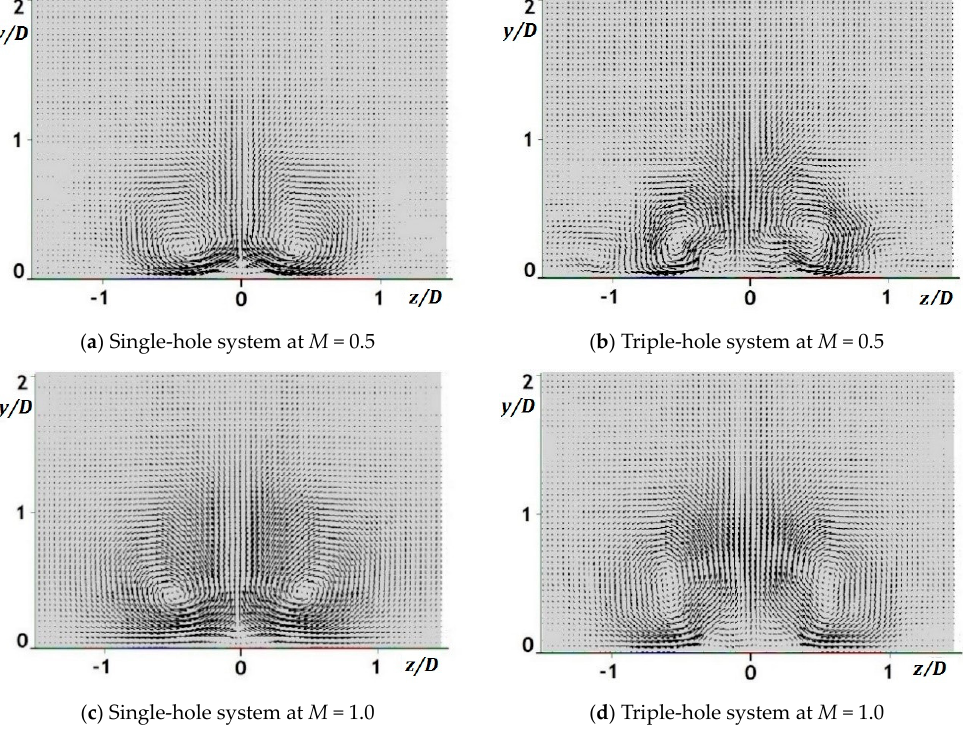
Figure 16. Cross-sectional velocity vectors at x/D = 2 for POD Mode 1.